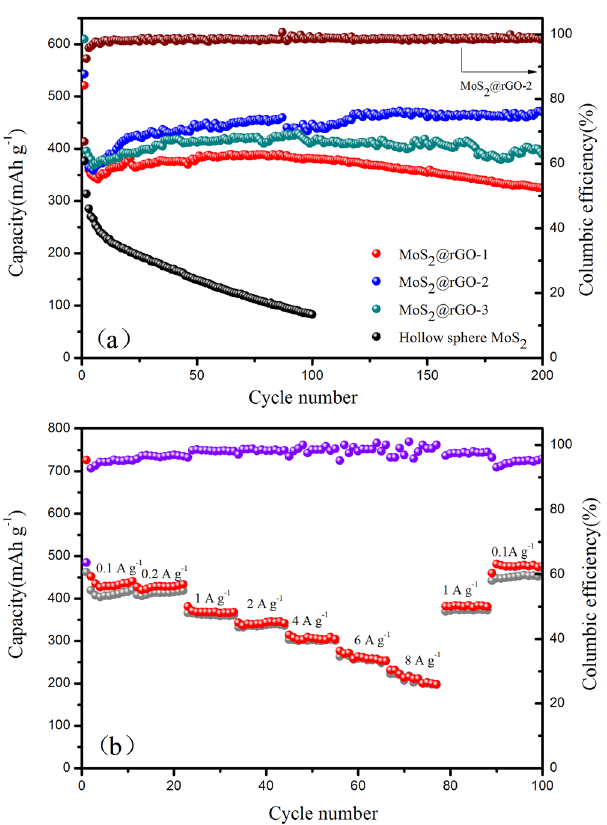
Figure 6. ( a ) The cycle performance of the pristine MoS 2 , MoS 2 /rGO-1,2,3 at 0.2 A g − 1 , ( b ) the rate performance of the MoS 2 @rGO-2 from 0.1 to 8 A g − 1